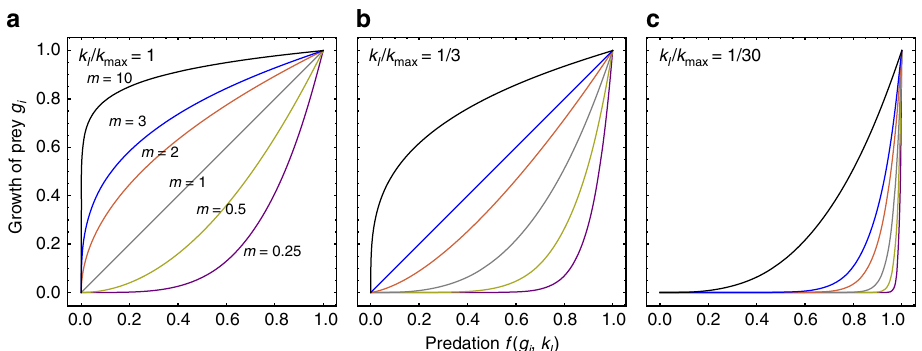
Fig. 3 The trade-off between predation f and prey growth g . a Illustration of the trade-off function between defense and prey growth in a naive predator population with the highest reproduction ef fi cacy k max . When m = 1, the trade-off function is linear, i.e., an increase in the growth will decrease the defense capability linearly and thus increase the predation rate linearly. When m > 1, the trade-off function is concave and defense is cheap. When m < 1, it is convex and defense is costly. The color refers to different m values marked beside each curve in a . If the predator species does not evolve, the trade-off curves will remain the same as in this panel. If the predator coevolves with the prey, the trade-off curves change, e.g., b , c show the trade-off curves under evolved predators with higher predation abilities, i.e., k l / k max equals to 1/3 or 1/30, respectively. With coevolution, the shapes of the trade-off functions will change continuously in different directions, depending on the present predator types